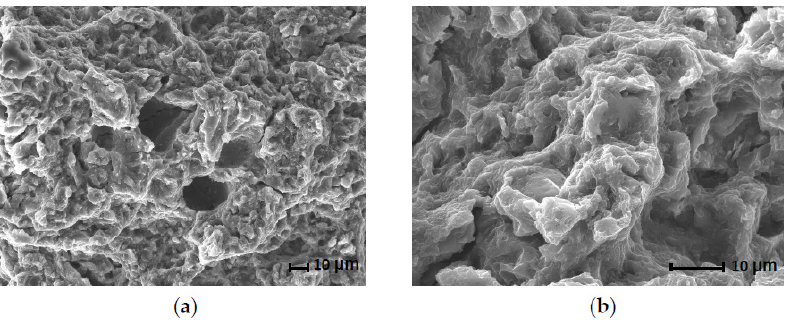
Figure 11. The fracture surface of sample 7-1: ( a ) spherical pores with cracks; ( b ) fine dimple morphology with hints of cleavage facets.